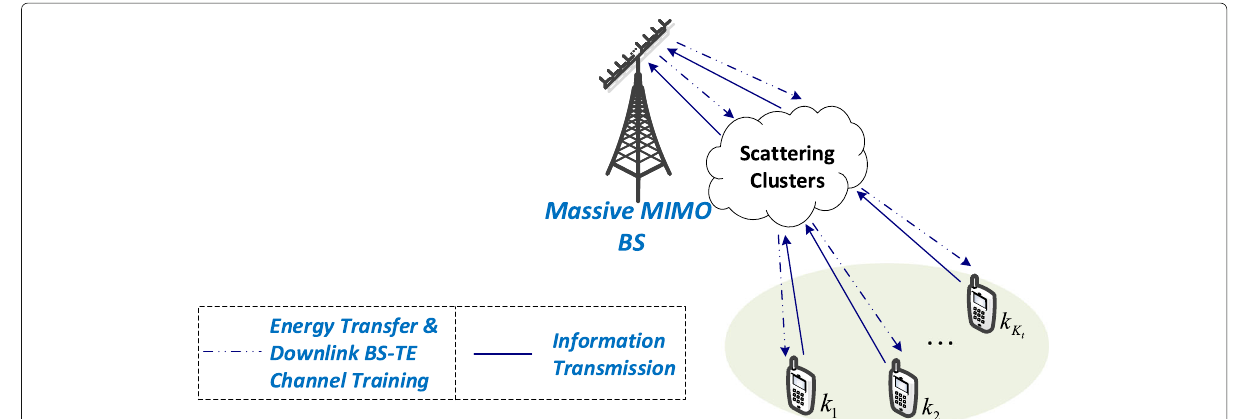
Fig. 1 Illustration of mMIMO SWIPT